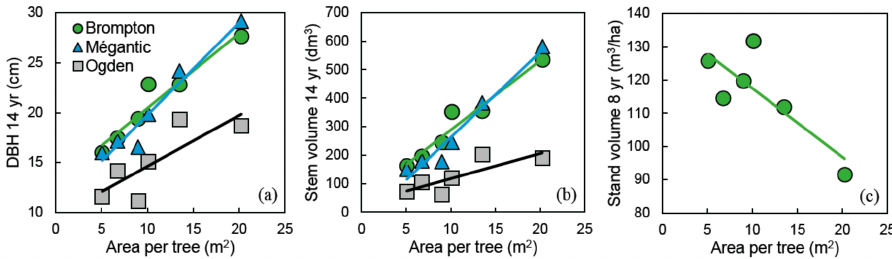
Figure 2. Site-specific linear relationships between area per tree at planting and ( a ) mean tree DBH after 14 years, ( b ) mean stem volume per tree after 14 years and ( c ) stand volume after 8 years in hybrid poplar plantations. Only relationships with p ≤ 0.05 are presented. Fit and significance level of the relationships are the following for panel ( a ): Brompton site (R 2 = 0.93, p < 0.01), Mégantic site (R 2 = 0.95, p < 0.01), Ogden site (R 2 = 0.65, p = 0.05); for panel ( b ): Brompton site (R 2 = 0.95, p < 0.001), Mégantic site